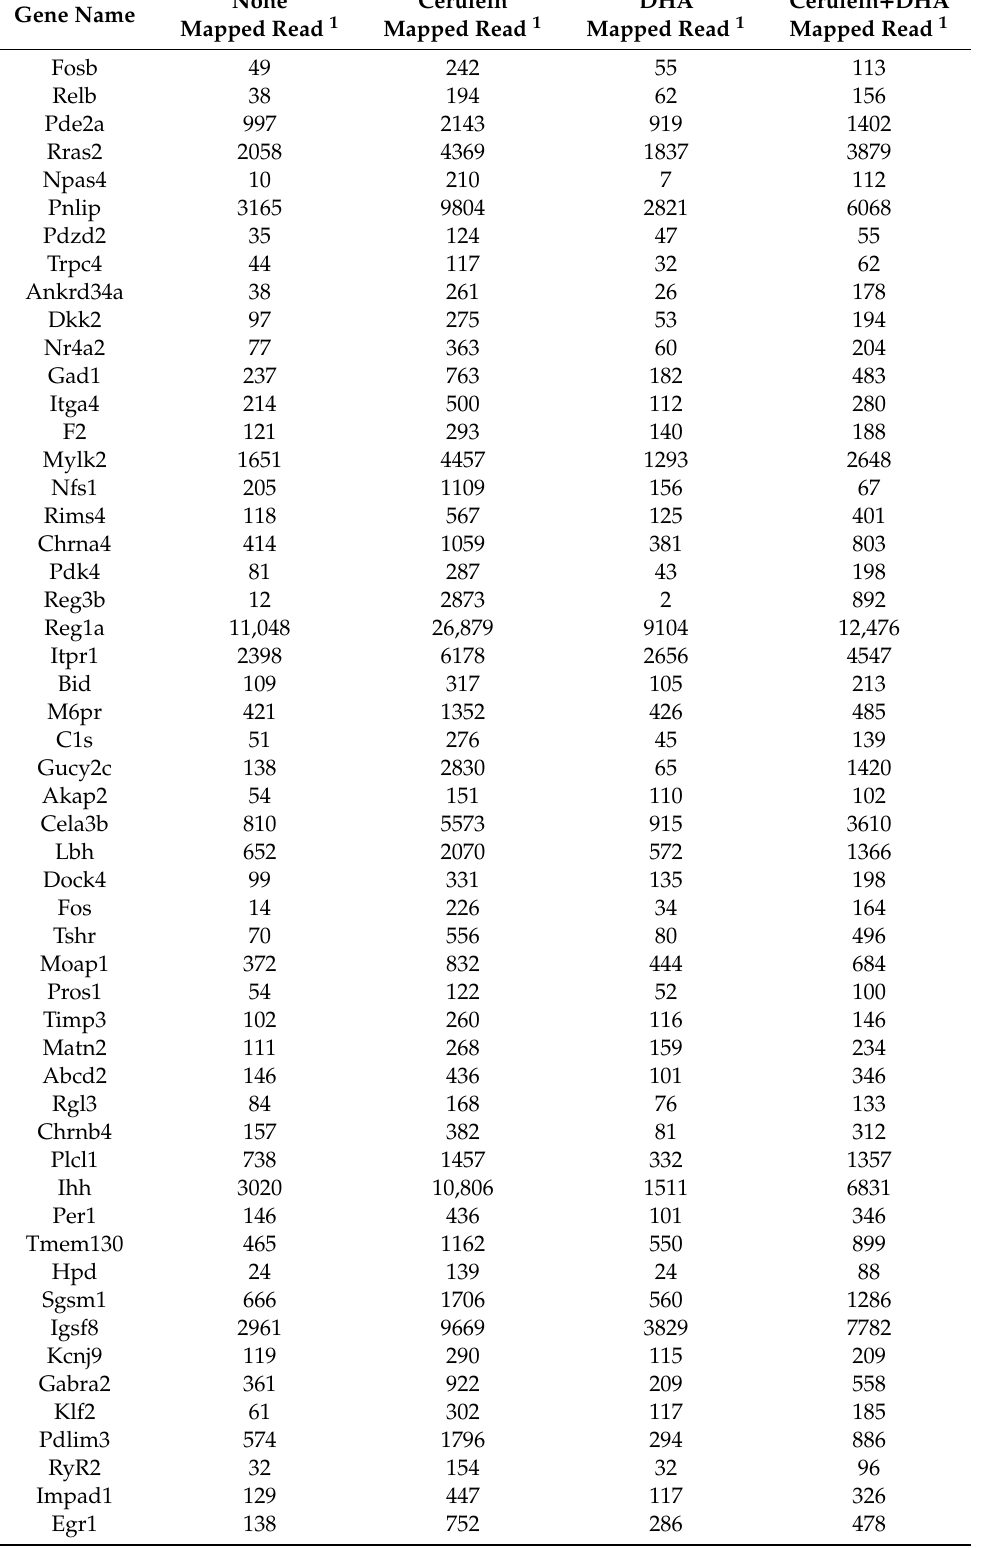
Table 1. Genes whose expressions were changed by treatment of cerulein or DHA or by pretreatment with DHA followed by cerulein